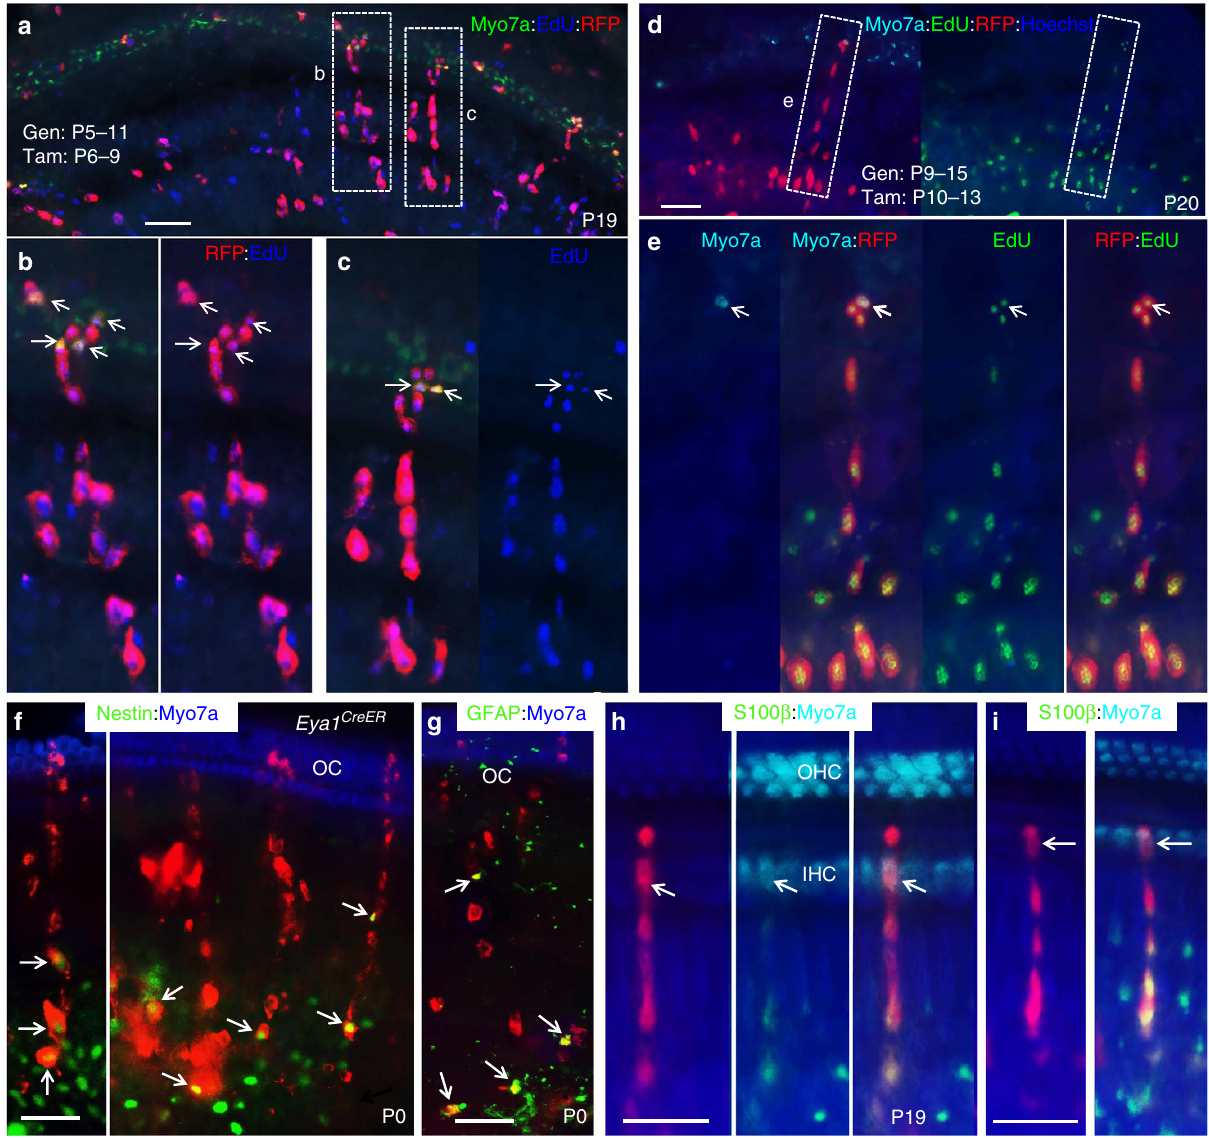
Figure 10 | Eya1 þ progenitors in mitotic hair cell regeneration and cell lineage tracing. ( a – c ) Merged images showing incorporation of EdU (blue) in all marked individual cells within red clones consisting of Myo7a þ HCs (green) (arrows) and surrounding Myo7a (cid:2) SCs within the sensory epithelium and their associated spiral ganglion cells in P19 Eya1 CreERT2 ;Rainbow cochleae treated daily with gentamicin from P5 to P11 and tamoxifen/EdU from P6 to P9. ( b , c ) Higher magnification of boxed areas in a . ( d , e ) Images showing incorporation of EdU (green) in all marked individual cells within a red clone consisting of Myo7a þ HCs (cyan) (arrow) and surrounding Myo7a (cid:2) SCs within the sensory epithelium and their associated spiral ganglion cells in P20 Eya1 CreERT2 ;Rainbow cochlea treated daily with gentamicin from P9 to P15 and tamoxifen/EdU from P10 to P13. ( e ) Higher magnification of boxed area. ( f – i ) Cell lineage tracing of multipotent progenitors by co-immunostaining of Eya1 CreER ;Rainbow cochlea at P0 (given tamoxifen at E12.5) with Myo7a (blue)/Nestin (greent) ( f ), Myo7a (blue)/GFAP (green) ( g ) or of Eya1 CreER ;Rainbow cochlea at P19 given tamoxifen at P10–P13 alone ( h ) or both gentamicin at P9–15/tamoxifen at P10–13 ( i ) with S100 b (green)/Myo7a (cyan) ( h , i ). Arrows point to Eya1 -lineage marked Myo7a þ IHC in the OC. Samples were counter-stained with Hoechst (blue). Scale bars: 50 m m ( a , d ); 30 m m ( b , c , e – i